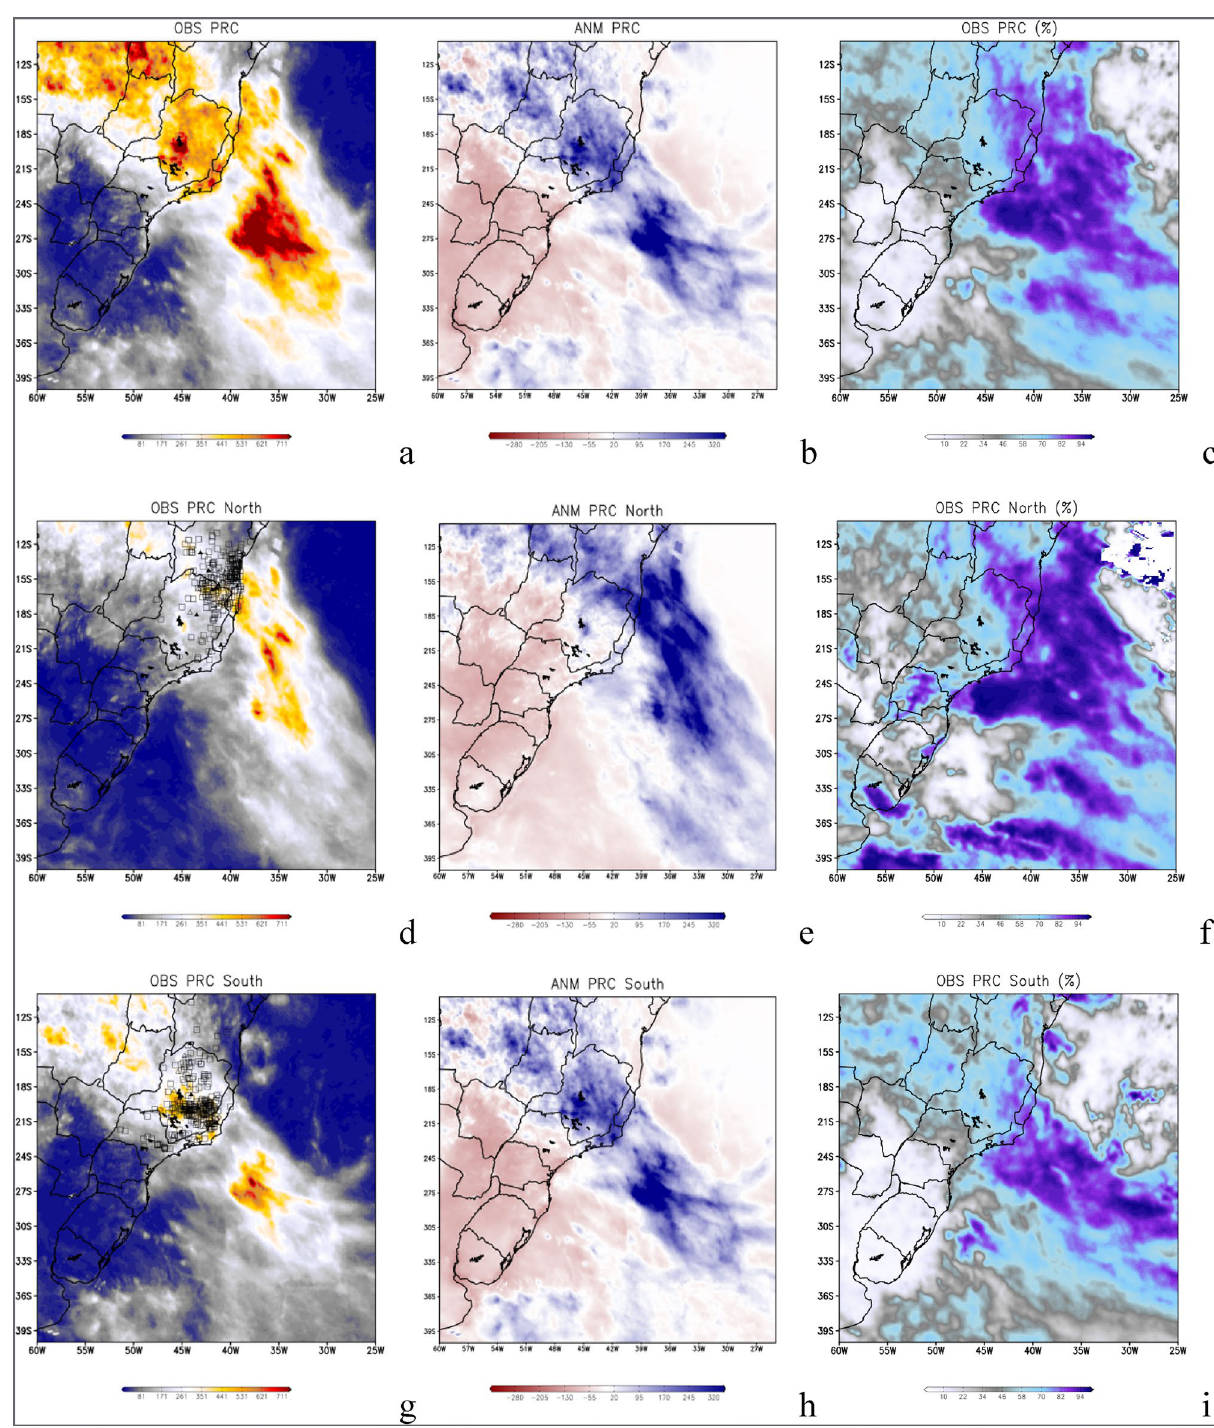
Figure 2. Satellite-derived accumulated ( a ) and anomalies ( b ) of precipitation (mm) over the seven oceanic South Atlantic Convergence Zone (SACZ) cases occurred during the South America summer of 2021/2022. Percentage of accumulated precipitation ( c ) from the seven oceanic SACZ compared to the accumulated climatological precipitation for the summer season (December, January, and February). Figures ( d–f ) are the same as the previous ones but for the cases where the oceanic SACZ were anchored towards the north in December 2021, and ( g–i ) to the south in January and February 2022. Grid Analysis and Display System (GrADS), Version 2.2.1.oga.1. http:// openg rads.